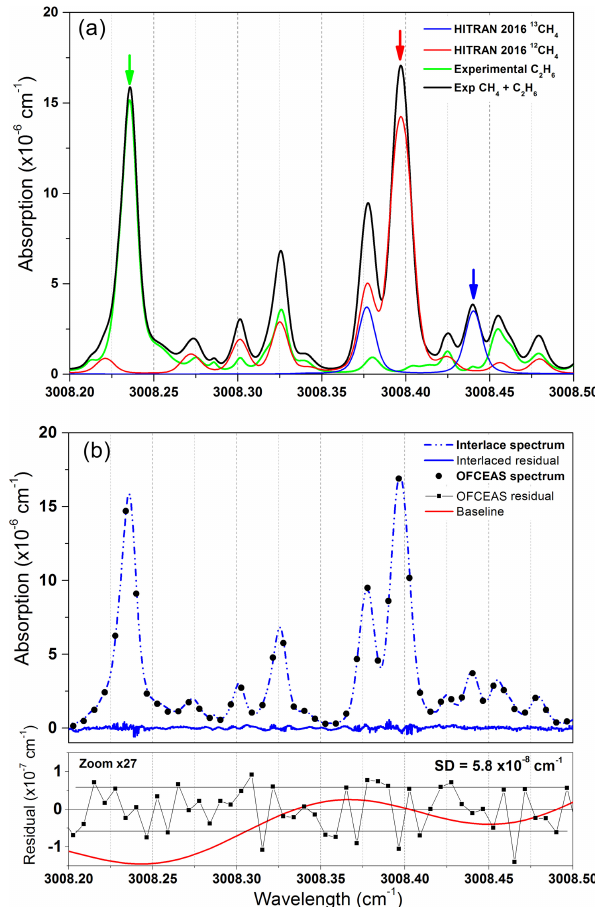
Figure 2. (a) A combination of experimental interlaced spectra and spectra simulated using the HITRAN 2016 database at 30mbar and 35 ◦ C. HITRAN profiles show the position of 12 CH 4 (red) and 13 CH 4 (blue) at 72ppmv of CH 4 in dry air. In green is the inter- laced spectrum acquired with only 20ppmv of C 2 H 6 in dry air in the cavity. The full experimental spectrum containing absorptions from the three species is reported in black. There is a disagreement for the two superimposed lines at 3008.39cm − 1 , with a line inten- sity discrepancy between experimental data and the HITRAN 2016 database of ∼ 16% on the amplitude of the absorption lines (this is outside the reported HITRAN 2016 uncertainties on the cross sec- tions that are between 2% and 5%). (b) An example of an OFCEAS spectrum (black circles) and the corresponding interlaced methane– ethane absorption spectrum and its residue (blue lines). At the bot- tom, the residuals of the OFCEAS spectral fit for one acquisition (0.1s) and the baseline curve (red) (generated by the fit) are re-